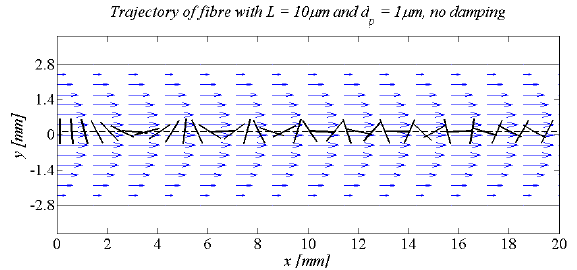
Fig. 6. Trajectory and orientation of a fibre with no damping